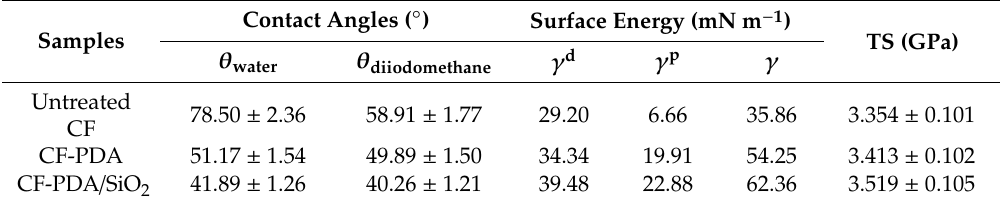
Table 2. Contact angles, surface energy, and tensile strength of different CFs.